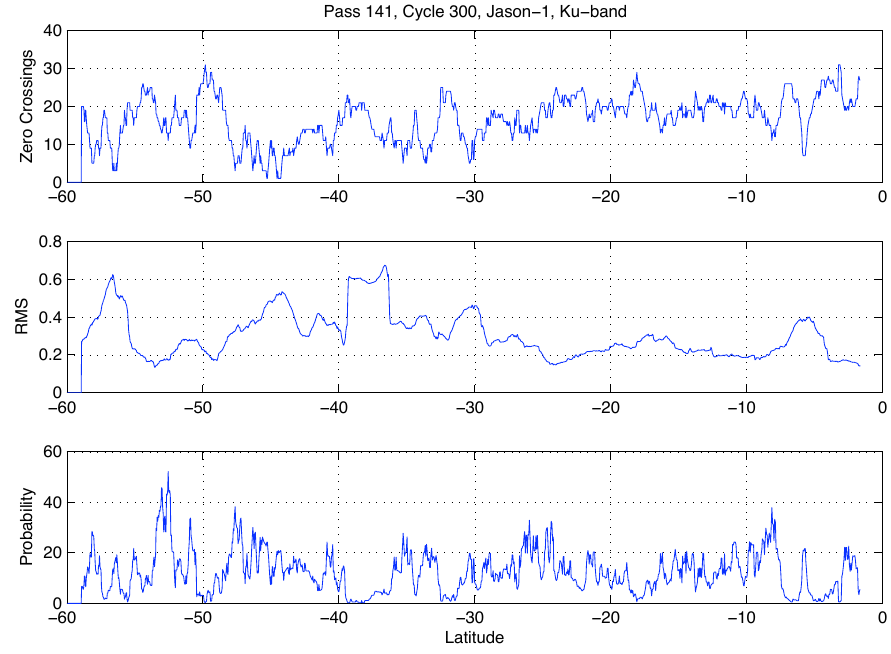
Fig. 11. Statistical randomization tests using a “sliding window” for pass 141 of Jason-1 cycle 300. A randomization test is conducted for every 3.2 ◦ window and the statistical significance is computed to test the hypothesis that the surface roughness variations with and without the tsunami present are not significantly different. The x-axis values represent the center point of each